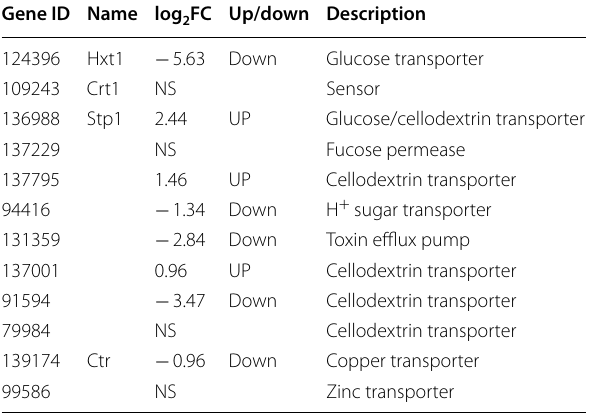
NS, nonsignificant at P adj > 0.05